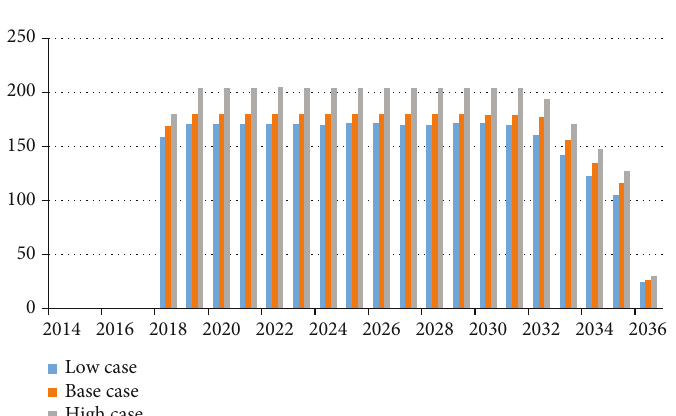
Figure 5: TEN gas production mmscfd.